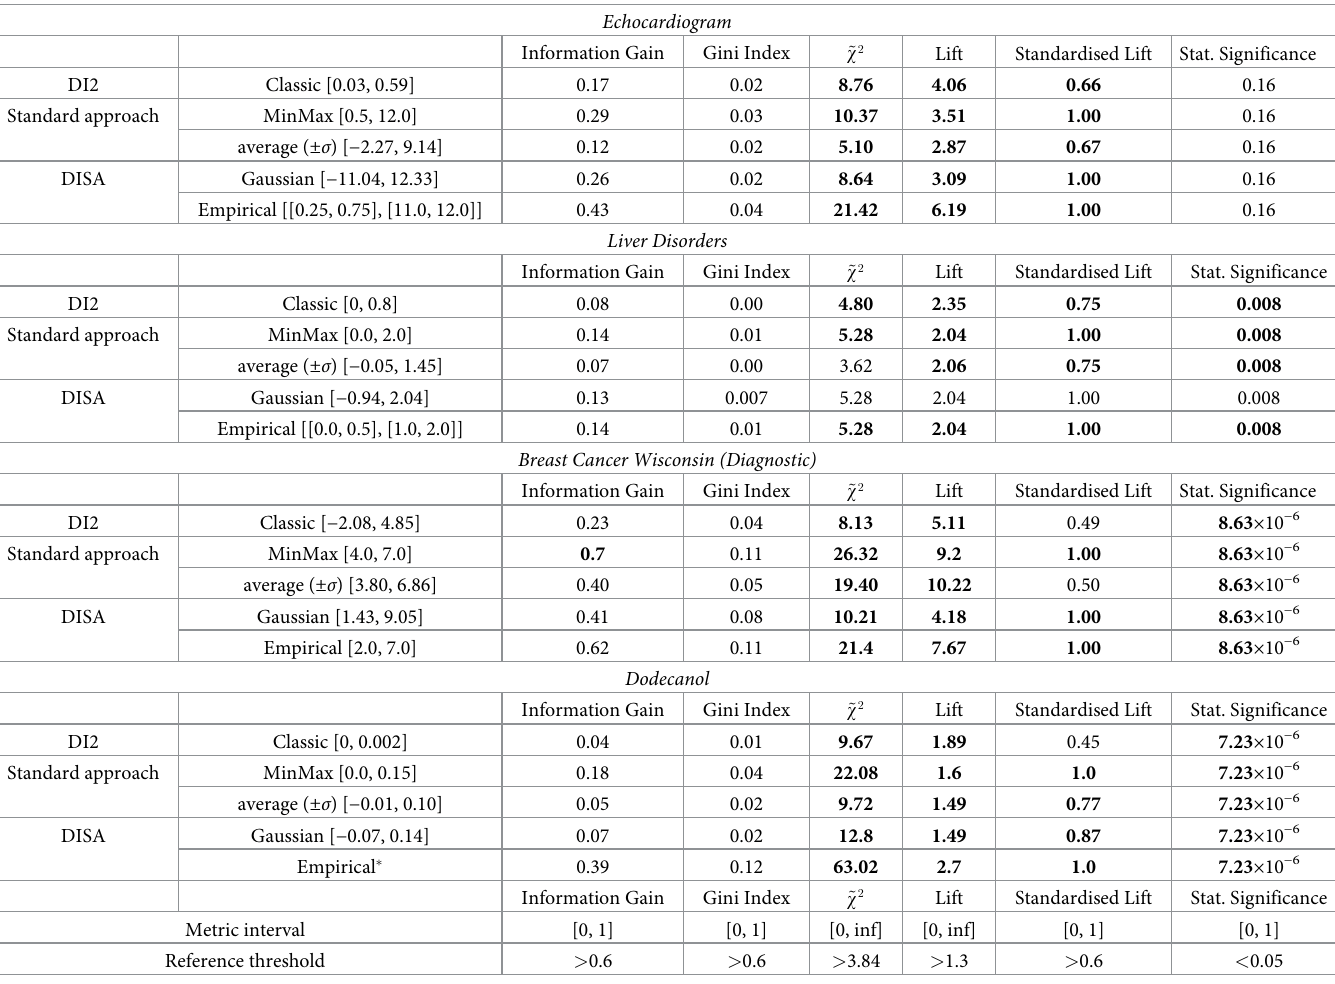
Table 5. Value of objective interestingness functions for each pattern in Fig 7. In this analysis, we compare the discriminative assessment produced over the range of discriminated outcomes with DISA against classic alternatives produced by discretizing the numerical outcome using DI2 [25] and the standard MinMax and Average approach (see Methods section) for the four datasets. The reference DISA values per function are presented in the last two